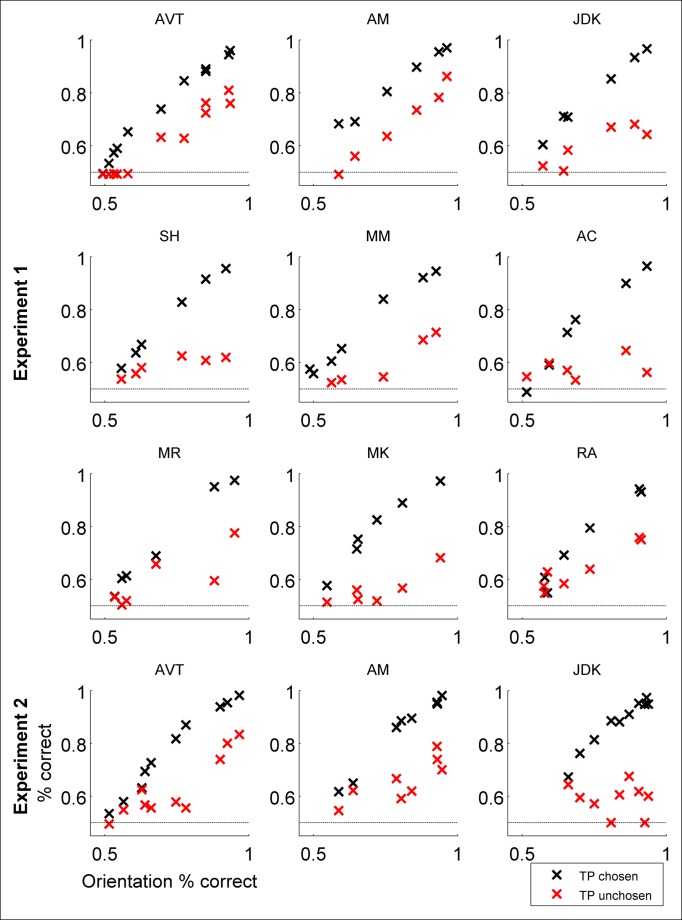
Individual subjects’ data for percent correct orientation discrimination conditional on having chosen to bet on the target-present (TP) interval or not.Individual subjects’ data closely resembles grouped data.The same three subjects participated in both Experiments 1 and 2.